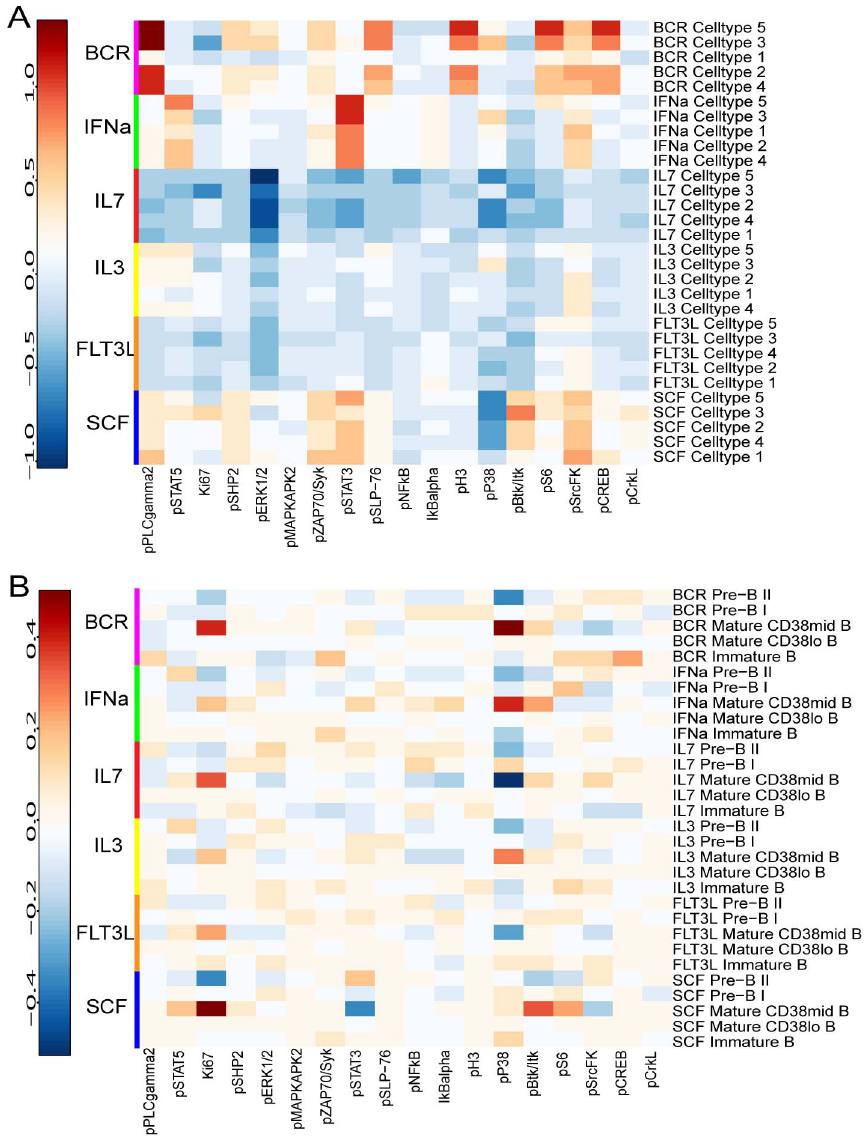
Figure 5. Signaling behavior in B-cell subtypes for CCAST vs manual gating strategy. A Heatmap of BCR, IFNa, FTL3, IL3, IL7, and SCF induced intracellular signaling responses in 5 B-cell CCAST-derived subtypes, compared with those of an unstimulated control. B Heatmap of BCR, IFNa, FTL3, IL3, IL7, and SCF induced intracellular signaling responses in the five B-cell subtypes obtained from the manual gates in Bendall et al. [9], compared with those of an unstimulated control. The higher difference implies a stronger signal in the CCAST-derived cell type compared to the manually gated cell type.